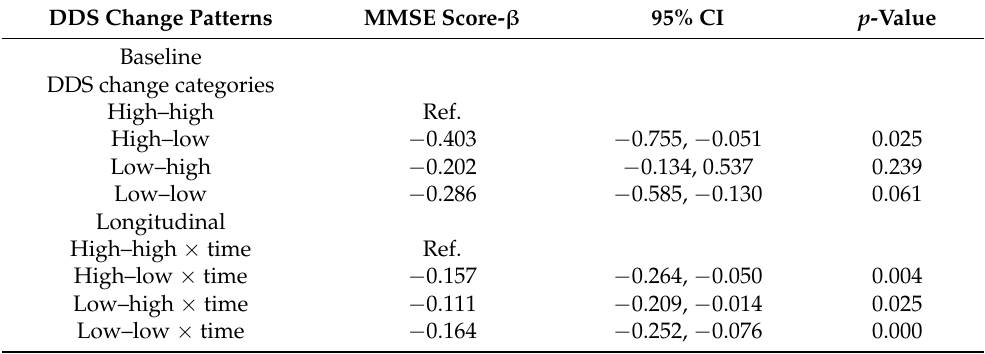
Table 5. β -Coefficients and 95% CI for the association of the DDS change patterns with MMSE score changes over follow-up time ( n = 6237). Results from the linear mixed-effects